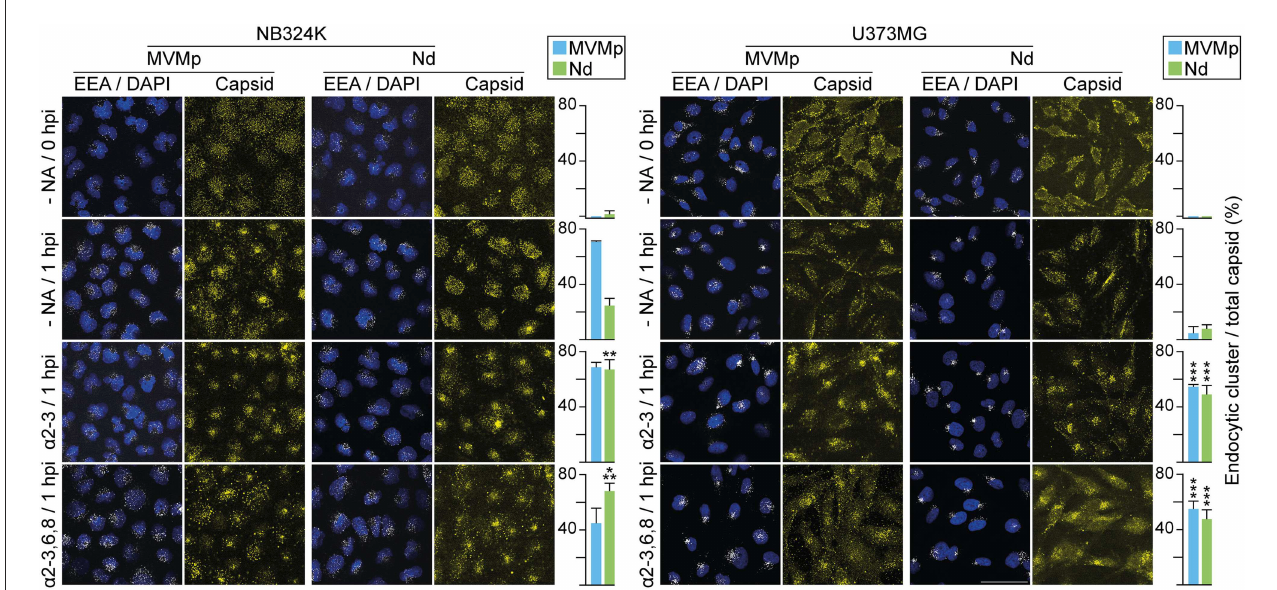
FIGURE6 Capsid contacts with sia(s) modulate intracellular parvovirus traffic to the endosome. Effect of capsid–sia contacts in viral traffic to the endosome. The figure illustrates confocal IF staining of MVM capsid ( α -MVM capsid polyclonal antibody) and the early endosomal (mouse anti-EEA1 antibody) of cells inoculated with equivalent amounts of purified virions (8 x 10 12 viral particles per 10 5 cells) adsorpted at 4 ◦ C (0 hpi) and further incubated 1h at 37 ◦ C (1 hpi). Treatments were performed with 2.5 x 10 − 2 U/ µ l of α -2-3-NA and 10 x 10 − 2 U/ µ l of α -2-3,6,8-NA sia cleaving neuraminidases. The number of endosomes showing accumulation as clusters of MVM capsid was quantitated as explained in Materials and Methods. Values correspond to the mean with standard errors obtained from three fields ( N = 10 2 cells). Statistics was obtained comparing the untreated to the NA-treated cell